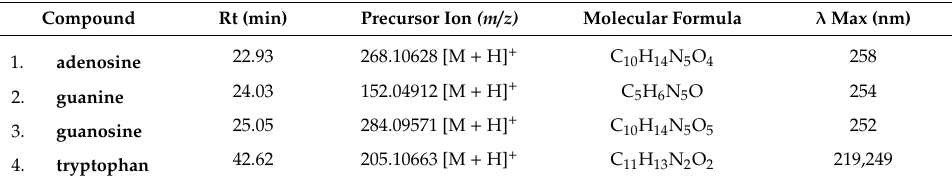
Figure 2. HPLC chromatogram of ( C. arietinum ) extract detected at 254 nm. Table 3. Retention time (Rt), precursor ion, molecule formula, and ultraviolet Maxima ( λ max) of identified peaks of C. arietinum